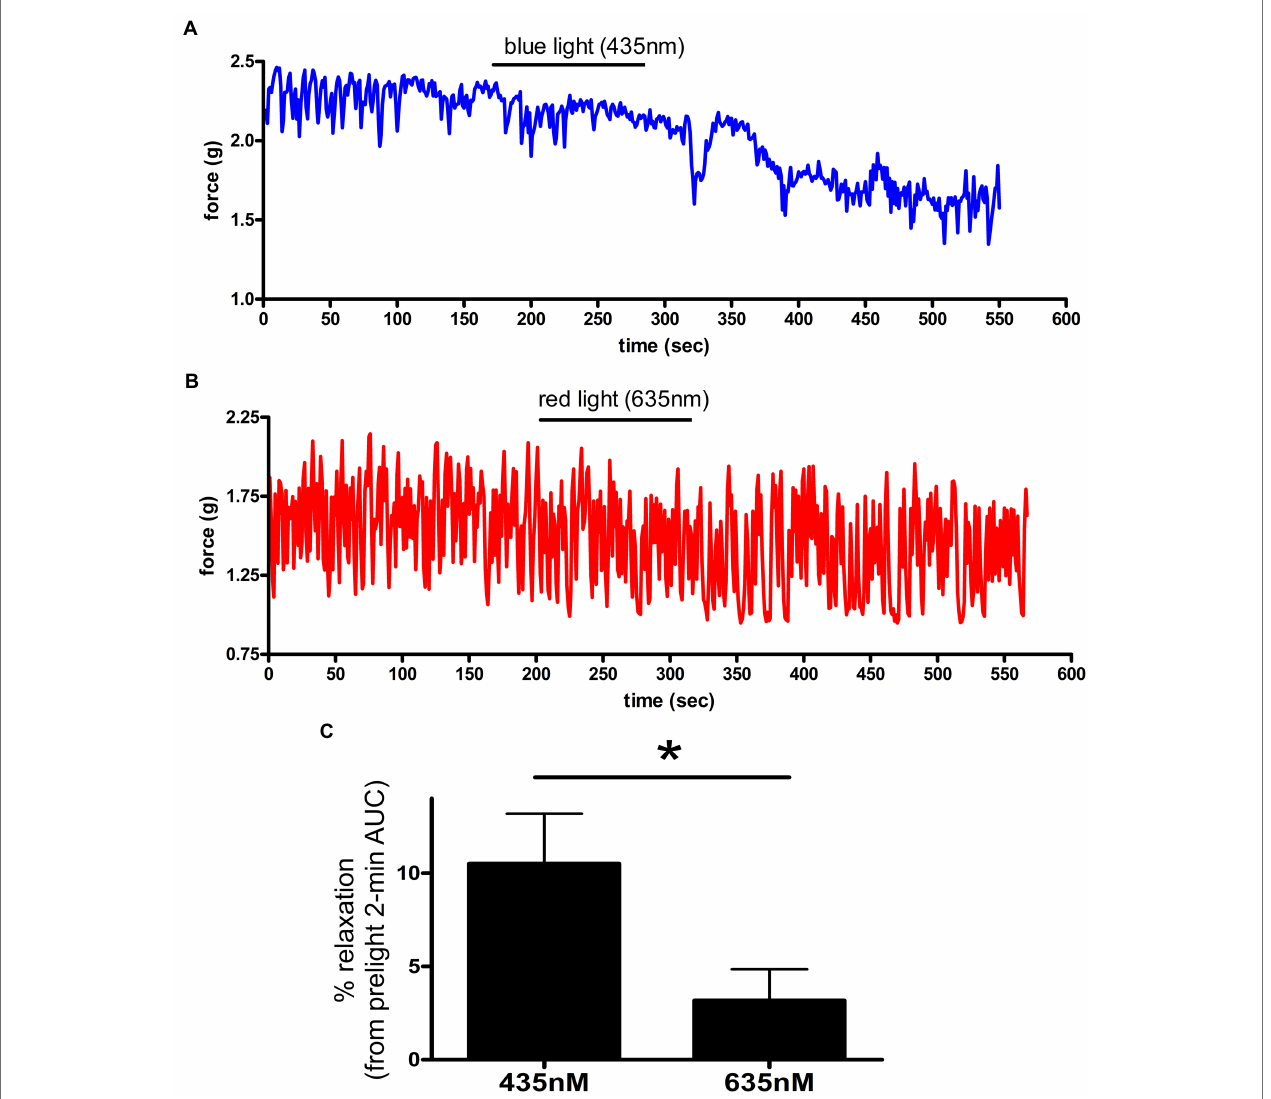
FIGURE 4 | (A,B) Representative muscle force tracings of ex vivo murine colon rings pretreated with TTX 1 μ M/9 -cis retinal 28 μ M and contracted with carbachol 100 μ M in wire myography experiments. Blue tracing (A) represents a colonic ring exposed to blue light (435 nm) indicated by the black bar. Colon ring represented by red tracing (B) was treated with 635 nm λ light as a negative control (duration indicated by the black bars). (C) AUC analysis of relaxation of ex vivo murine colon rings precontracted with carbachol and TTX/9- cis retinal pretreatment. Rings exposed to 435 nm λ light demonstrated a 10 ± 2.7% relaxation, while the 635 nm λ light group demonstrated a 3.2 ± 1.7% relaxation (mean ± SEM, * p < 0.05, n = 5–6